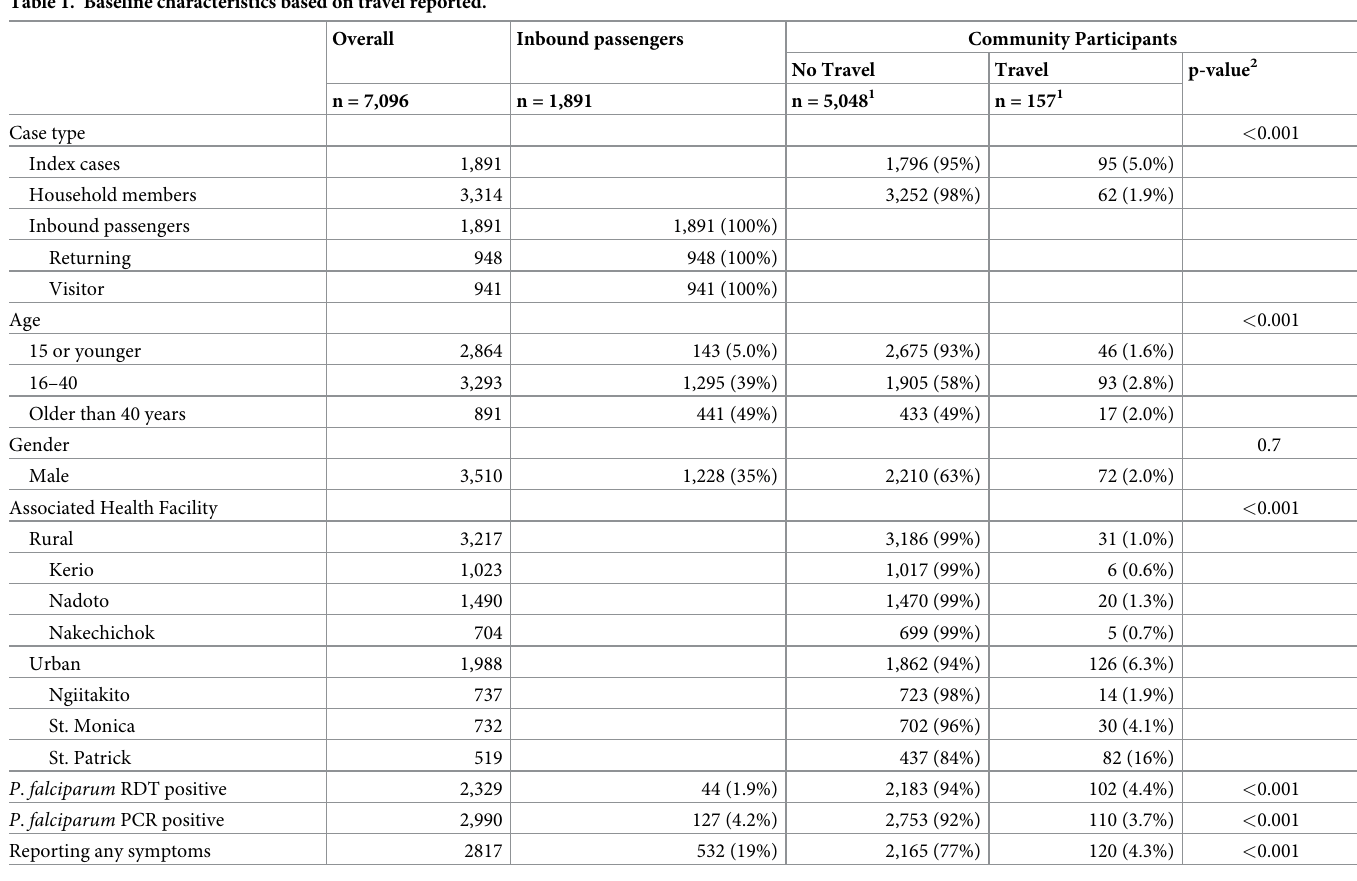
Table 1. Baseline characteristics based on travel